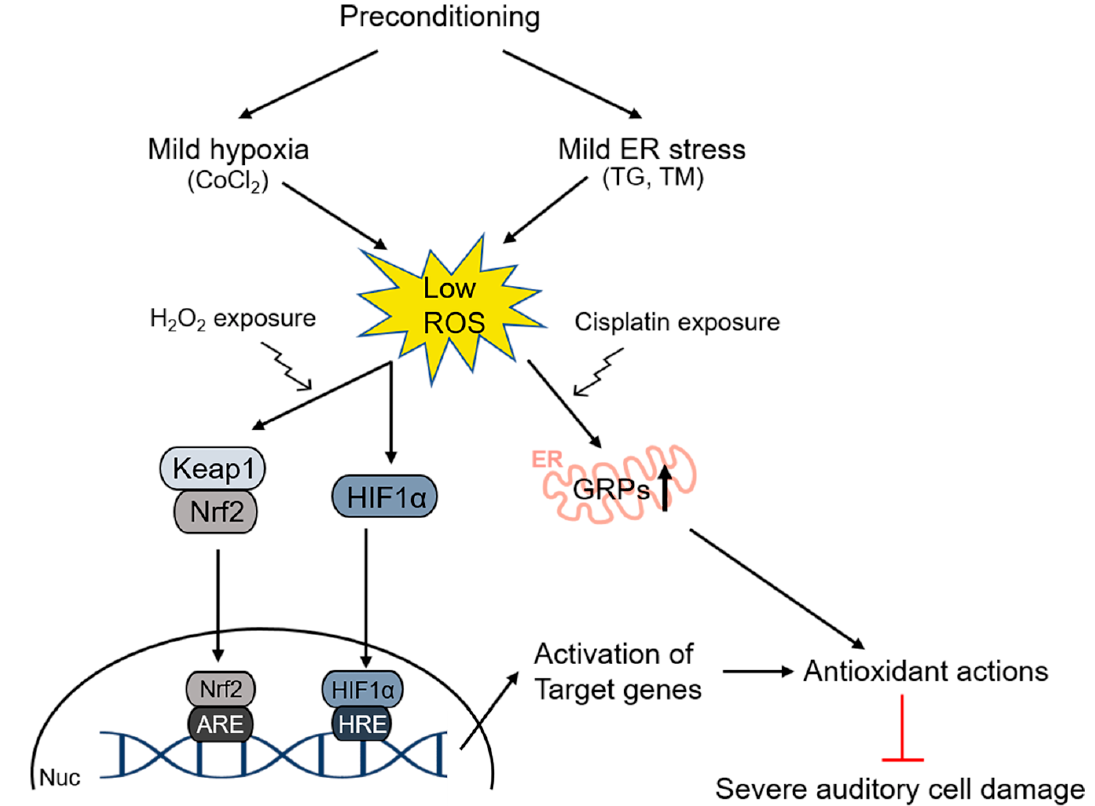
Figure 2. Example of preconditioning effects on ototoxicity induced by auditory hair cell exposure to H 2 O 2 and cisplatin. Prior to the exposure to half-maximal cytotoxic doses of H 2 O 2 or cisplatin, HEI-OC1 cells were pretreated with CoCl 2 , thapsigargin, or tunicamycin. These pretreatments resulted in reduced levels of ROS, thereby protecting cells from apoptotic cell death caused by subsequent oxidative stress. Red lines indicate the blocking of the cell damage by antioxidants. ER, endoplasmic reticulum; TG, thapsigargin; TM, tunicamycin; GRPs, glucose-related proteins; Nrf2, nuclear factor erythroid-2-related factor 2; HIF1 α , hypoxia-inducible factor 1-alpha; ARE, antioxidant response element; HRE, hypoxia response element; Nuc, nucleus.